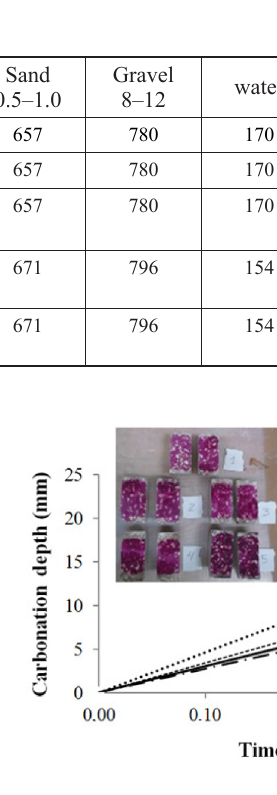
Fig. 1. Results of the accelerated carbonation tests